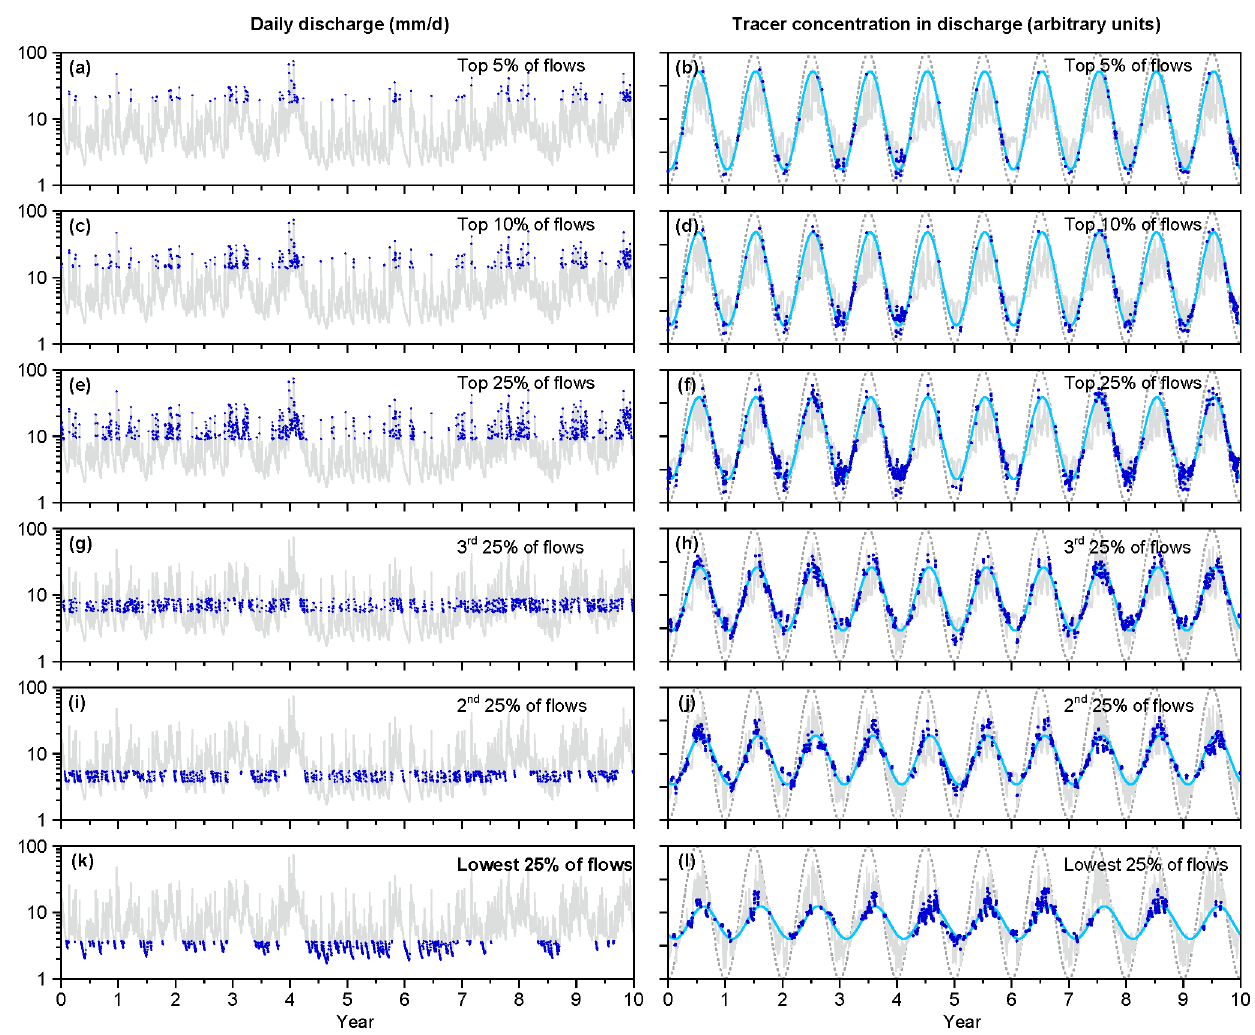
Figure 8. Daily discharges (left panels) and tracer concentrations (right panels) in streamflow from the two-box model with reference parameter values and Plynlimon precipitation forcing. Individual discharge ranges and corresponding tracer concentrations are highlighted in dark blue. In the right-hand panels, precipitation tracer concentrations are shown by dashed gray lines and sinusoidal fits to streamflow tracer concentrations are shown in light blue. At higher discharges, tracer cycles are less damped and less phase-shifted, indicating greater fractions of young water in